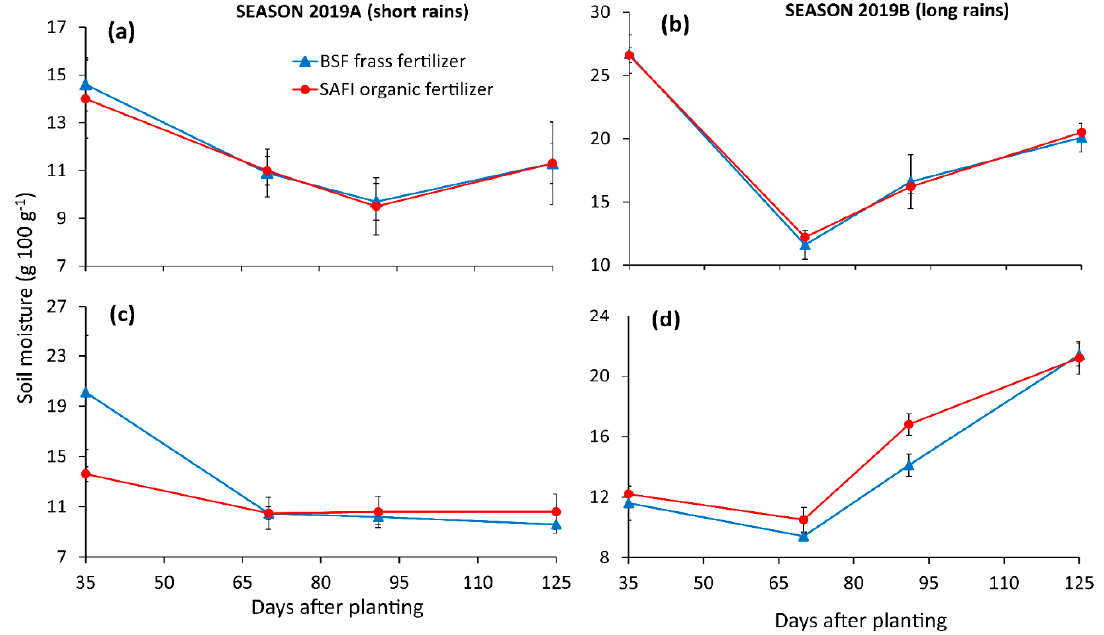
Figure 1. Soil moisture content in the topsoil (0–20 cm) ( a , b ) and subsoil (20–40 cm) ( c , d ), during the short and long rain season experiments.